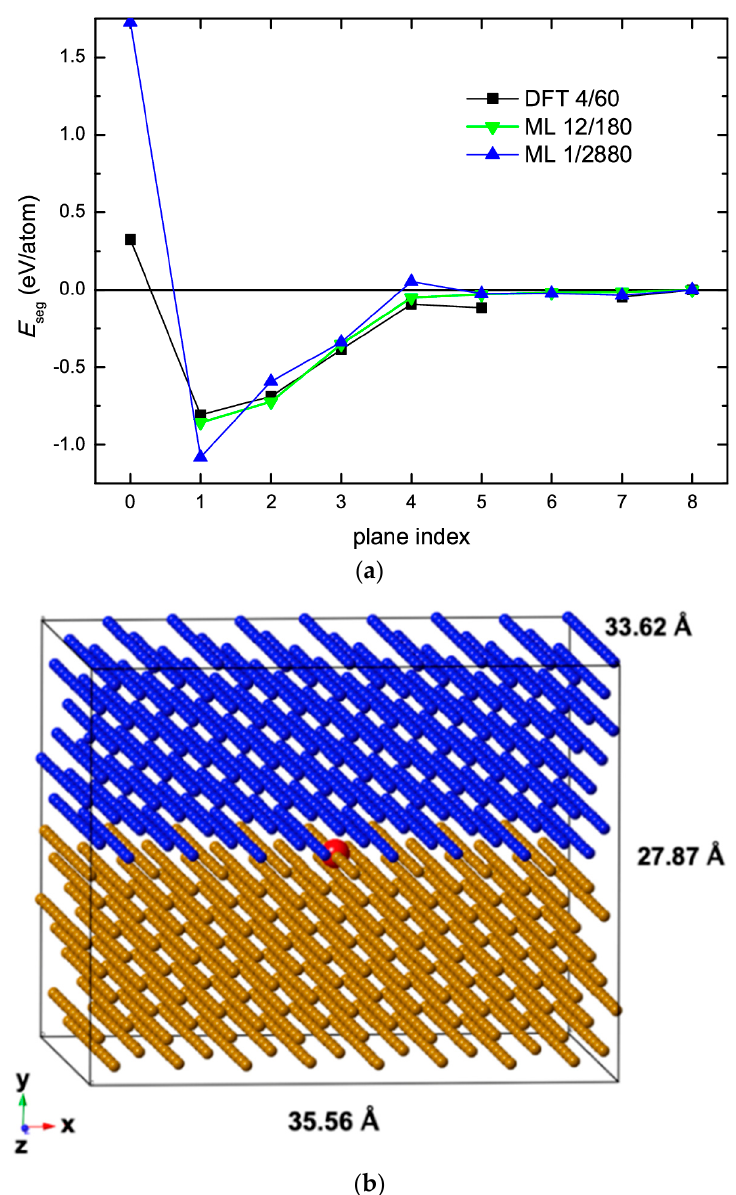
Figure 4. ( a ) Segregation energy computed using DFT and ML. The legend also contains the number of solute atoms and the total number of atoms in the supercell. ( b ) Illustration of the computational supercell with 2880 atoms and a single substitutional impurity atom in the GB plane.